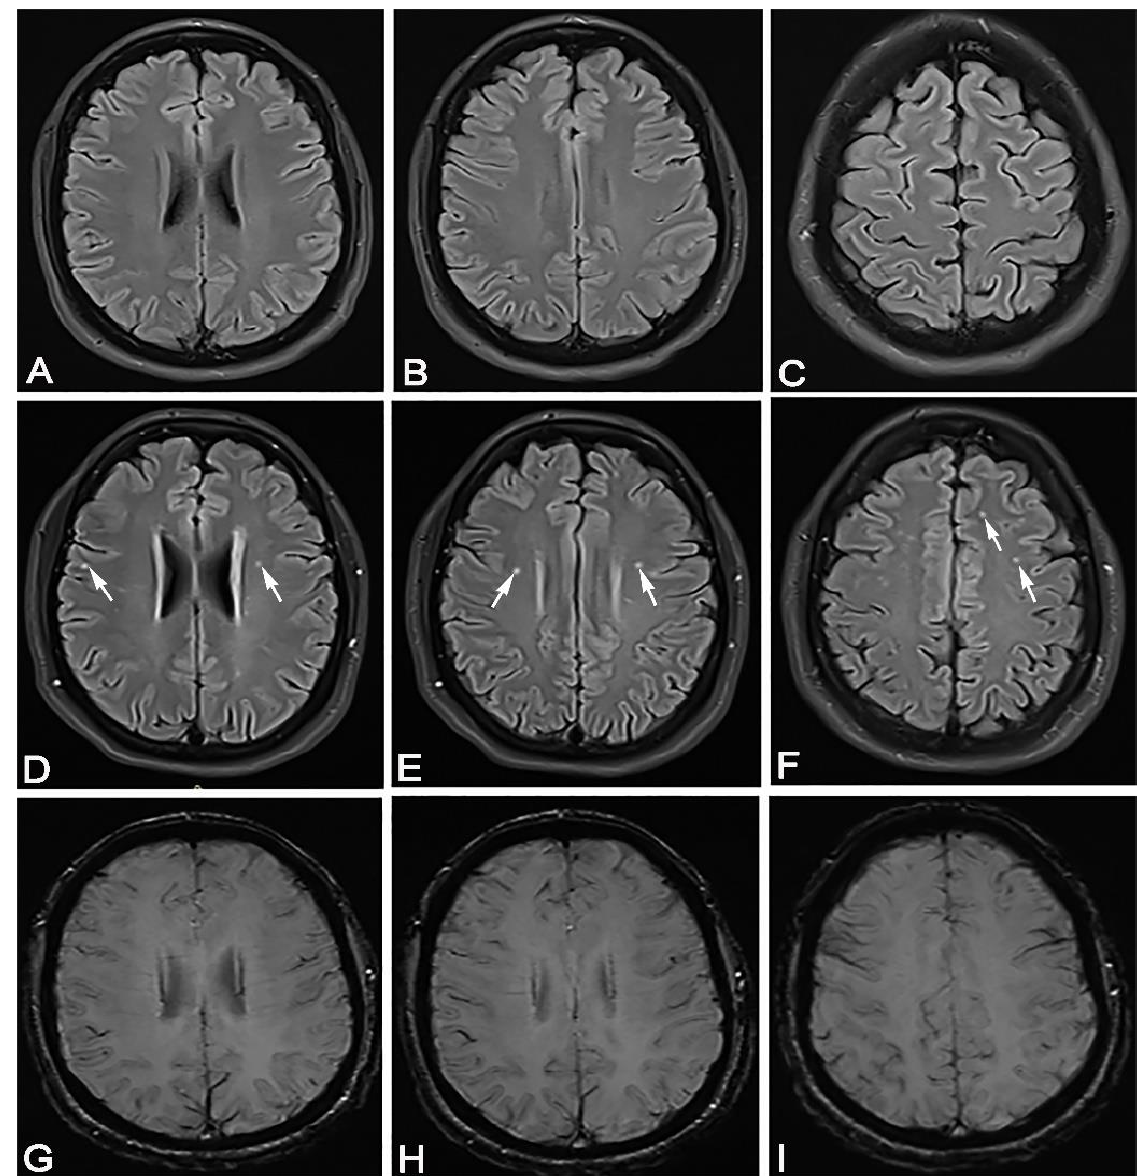
Figure 3. In April 2020, a 35-year-old female patient came for a brain MRI due to vertigo. ( A – C ) She showed completely normal brain MRI. In February 2021, 50 days after recovering from mild SARS-CoV-2 infection, the same patient came for a brain MRI due to headache, vertigo and taste and smell disorder. ( D – F ) She showed hyperintense lesions on FLAIR sequence, periventricular bilaterally, bifrontal subcortical and right juxtacortical (white arrows). The same transverse cross sections of the FLAIR sequence as on ( A – C ), without signs of microhemorrhage on the SWI sequence ( G – I ). All included 39 patients had nonspecific neurological symptoms such as smell and taste dysfunction, vertigo, headache, dizziness or fatigue. All subjects overcame SARS- CoV-2 infection from 40 to 60 days before MRI brain scan. The control group was 16 healthy volunteers (voluntary blood donors) who had no symptoms of SARS-CoV-2 in- fection and who were seronegative for SARS-CoV-2 IgG and IgM antibodies. All subjects